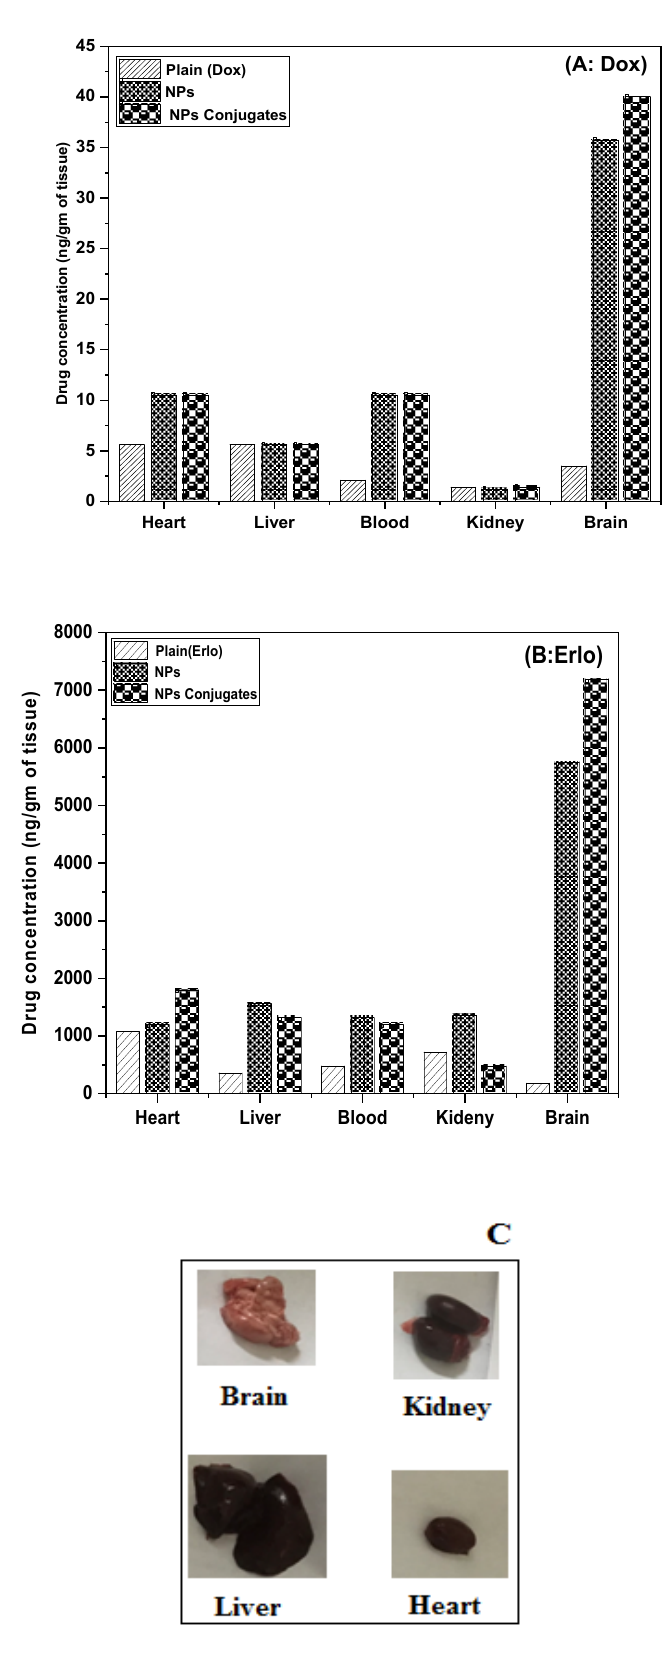
Figure 11. Graph representing the biodistribution of Dox ( A ) and Erlo ( B ) from plain, Dox–Erlo NPs, and Dox–Erlo-NP conjugates. Isolated organs of animals after 24 h of dose ( C